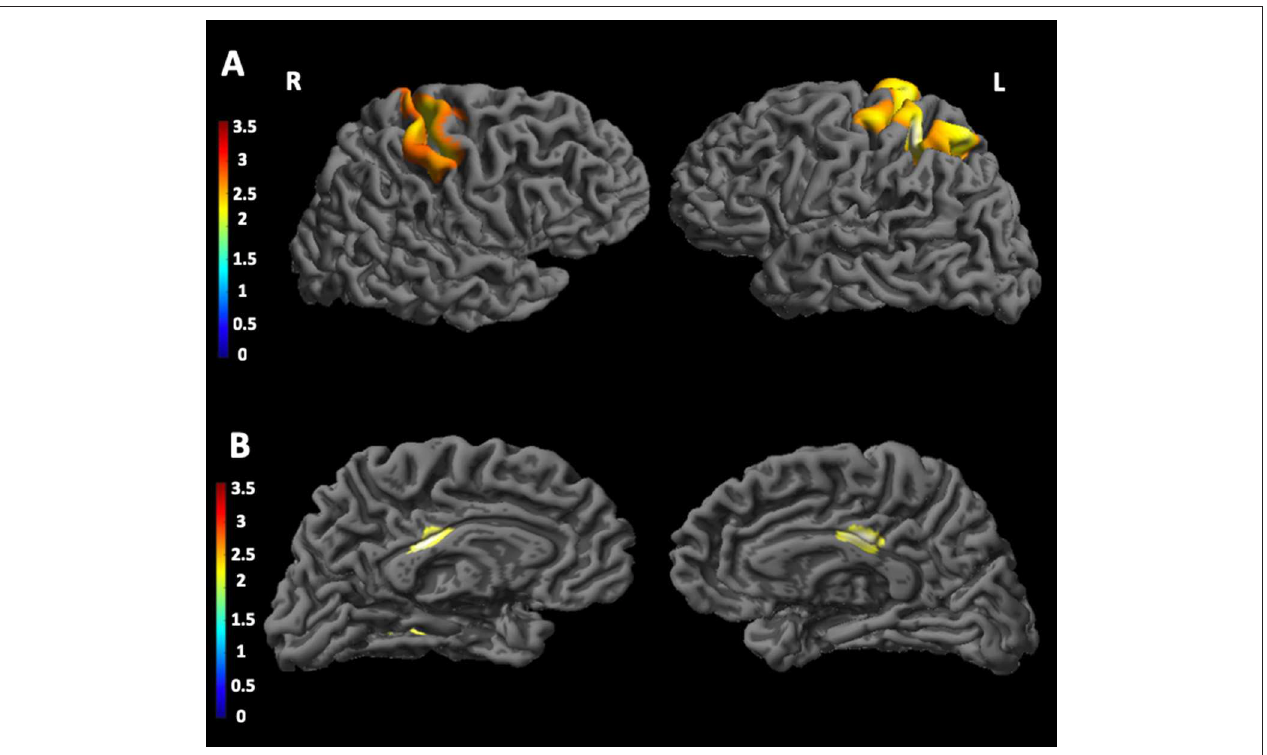
FIGURE 2 | Correlations between CTG triplet expansion and cortical thickness in DM1 patients. The figure shows the correlations between CTG triplet expansion and the cortical thickness in different brain areas. In particular, (A) shows a significant positive correlation between CTG triplet expansion and cortical thickness in the left postcentral gyrus and in the left primary somatosensory cortex; (B) shows a significant negative correlation between CTG triplet expansion and cortical thickness in the posterior cingulate cortex bilaterally and in the right lingual gyrus. The statistical comparisons were overlapped on MRIcron ch2bet template (https://www.nitrc. org/projects/mricron). L, left; R,